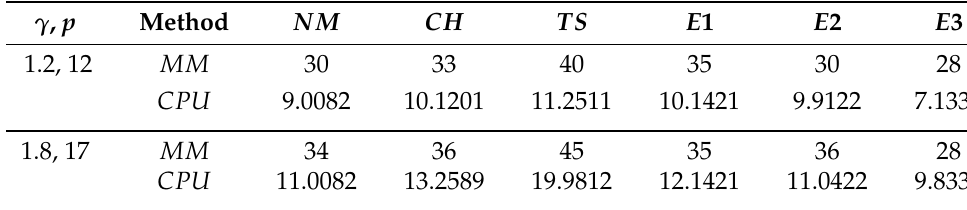
Table 7. Results of Example (6) case (a).